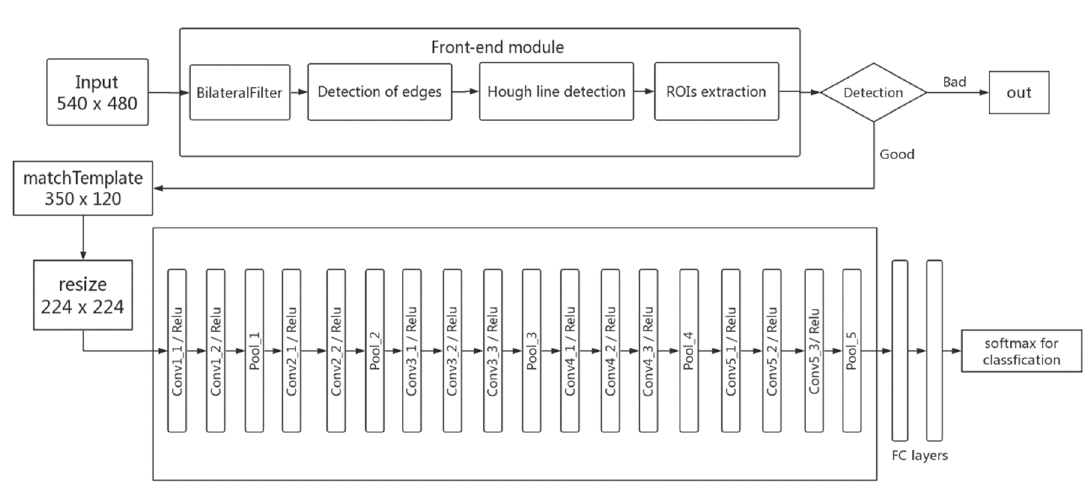
Figure 3. Architecture of our proposed intelligent vision system. The front-end module part takes the original images as inputs and the DCNNs part takes the extracted ROC as input if needed.